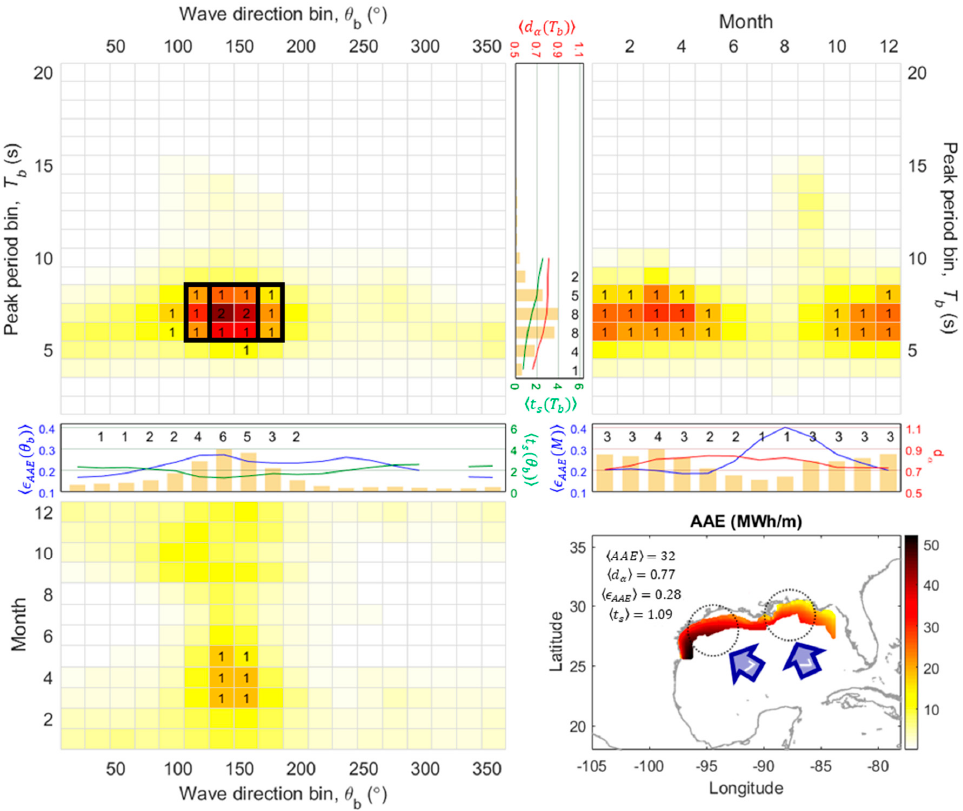
Figure 8. [Region 7: Gulf of Mexico—Western and Central Coast] The detailed descriptions are identical to Figure 2.